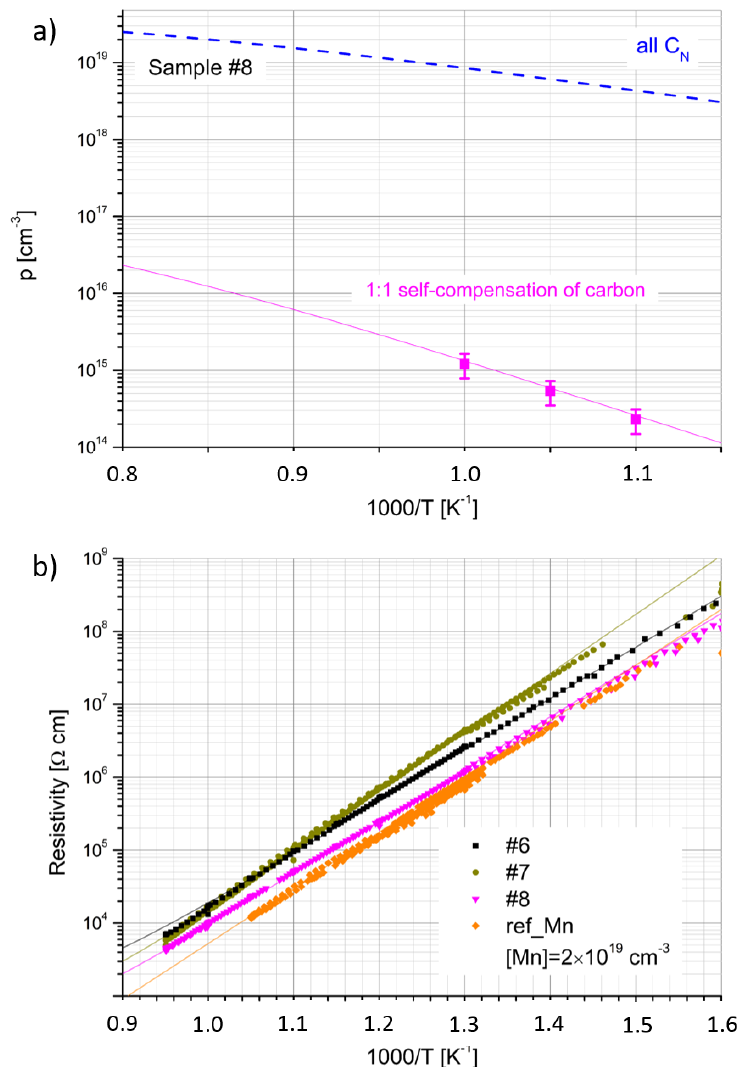
Figure 4. ( a ) Hole concentration (p) as a function of inverse temperature for GaN:Mn,C (sample #8); pink solid line represents the solution of charge neutrality equation using the self-compensation ratio of C equal to 1 and fitting parameters presented in Table 4; blue dashed curve represents similar modeling results, assuming all C acting as C N acceptors; ( b ) resistivity of all GaN:Mn,C crystals; and solid lines represent the calculation of resistivity using modeled hole concentration (in panel ( a )) and assuming mobility listed in Table 4. For comparison, a highly Mn-doped sample ref_Mn, taken from previous work [15], is presented.